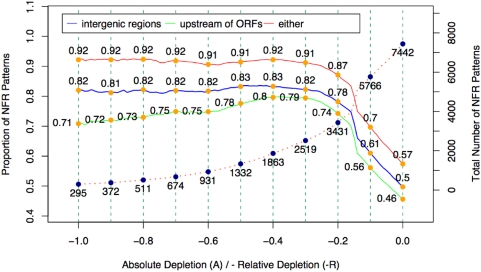
Mapping the locations of NFRs with various DoND.The proportions of NFR patterns located at intergenic regions, 500bp upstream regions of ORFs, and either regions given different cutoffs of DoND. Specifically, the cutoff α (α<0) indicates that the absolute depletion is smaller than α and the relative depletion is bigger than -α. The dash line indicates the total number of NFR patterns at different cutoffs (corresponding to the axis on the right side).